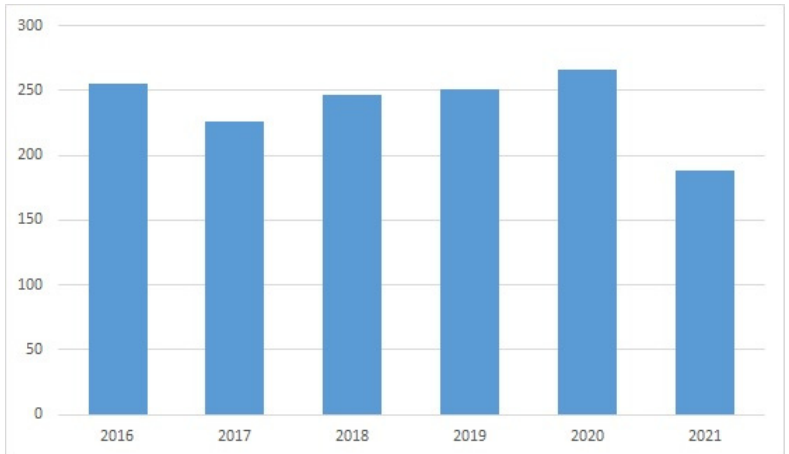
Figure 4. Proposal and results of bibliographic review.